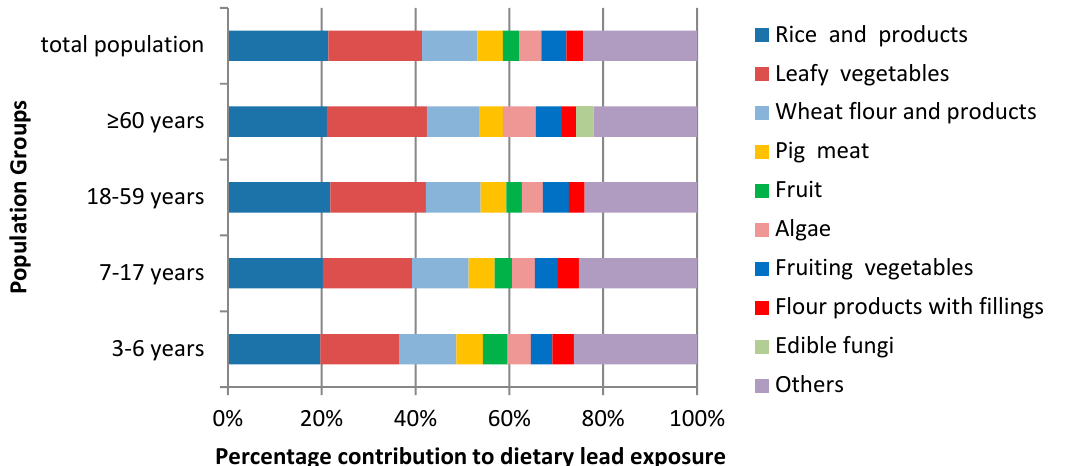
Figure 2. Population age groups and major food contributors to dietary lead exposure.